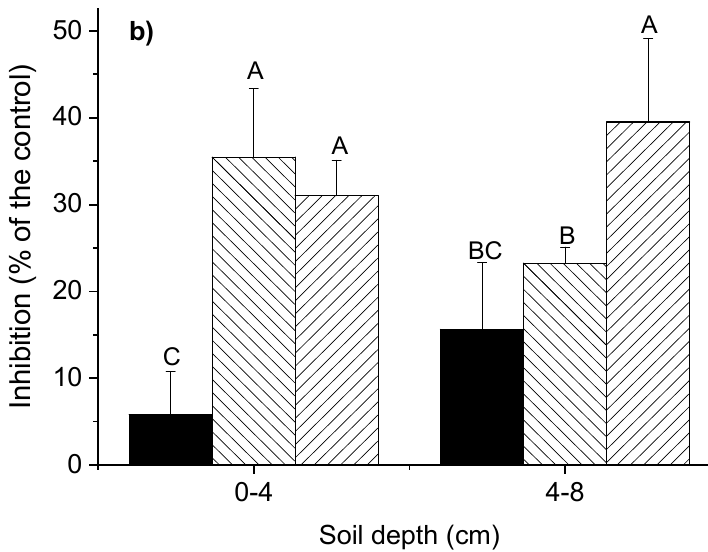
Figure 3. Percentage retained in soil column experiments ( a ) and herbicidal activity in the upper segments ( b ). Means followed with the same letter are not significantly different according to Student’s multiple range test at p = 0.05.